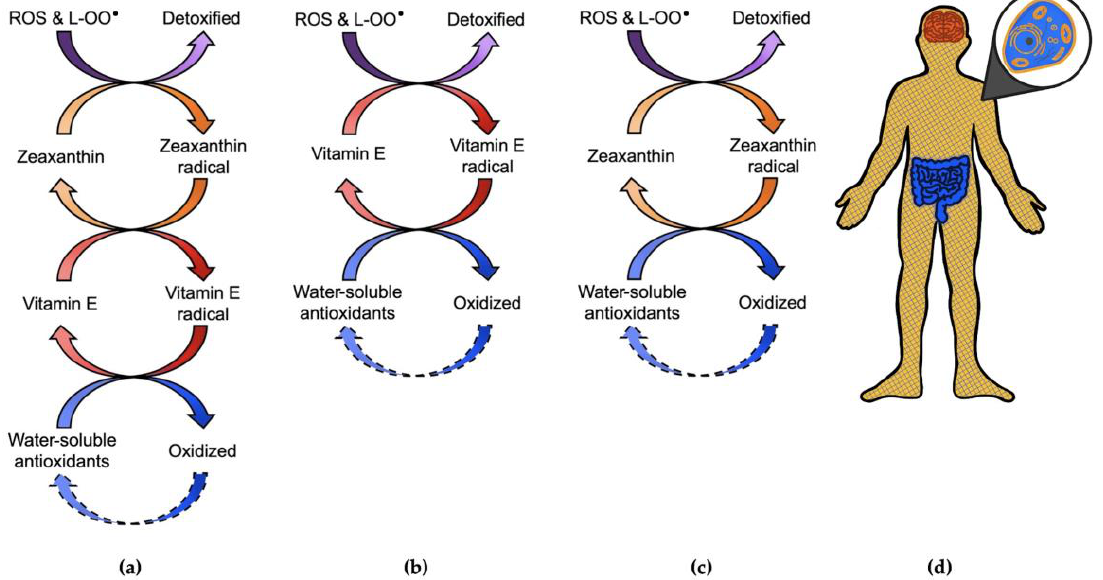
Figure 3. ( a ) Schematic depiction of the intertwined oxidation-reduction cycles that allow recycling (via re-reduction) of zeaxanthin radical by vitamin E after zeaxanthin has detoxified (reduced) ROS and/or lipid peroxyl radicals (L-OO • ), followed by recycling of vitamin E radical by water soluble antioxidants. ( b ) Schematic depiction of recycling of vitamin E radical by water soluble antioxidants. ( c ) Schematic depiction of direct recycling of zeaxanthin radical by water soluble antioxidants. ( d ) Outline of the human body highlighting the gut with water-soluble dietary polyphenols (dark blue), cells (top-right magnification) throughout the body with aqueous cytosol and inner and outer membranes (light orange with blue hatches), and a high concentration of membranes with their lipid-soluble antioxidants in the brain (dark